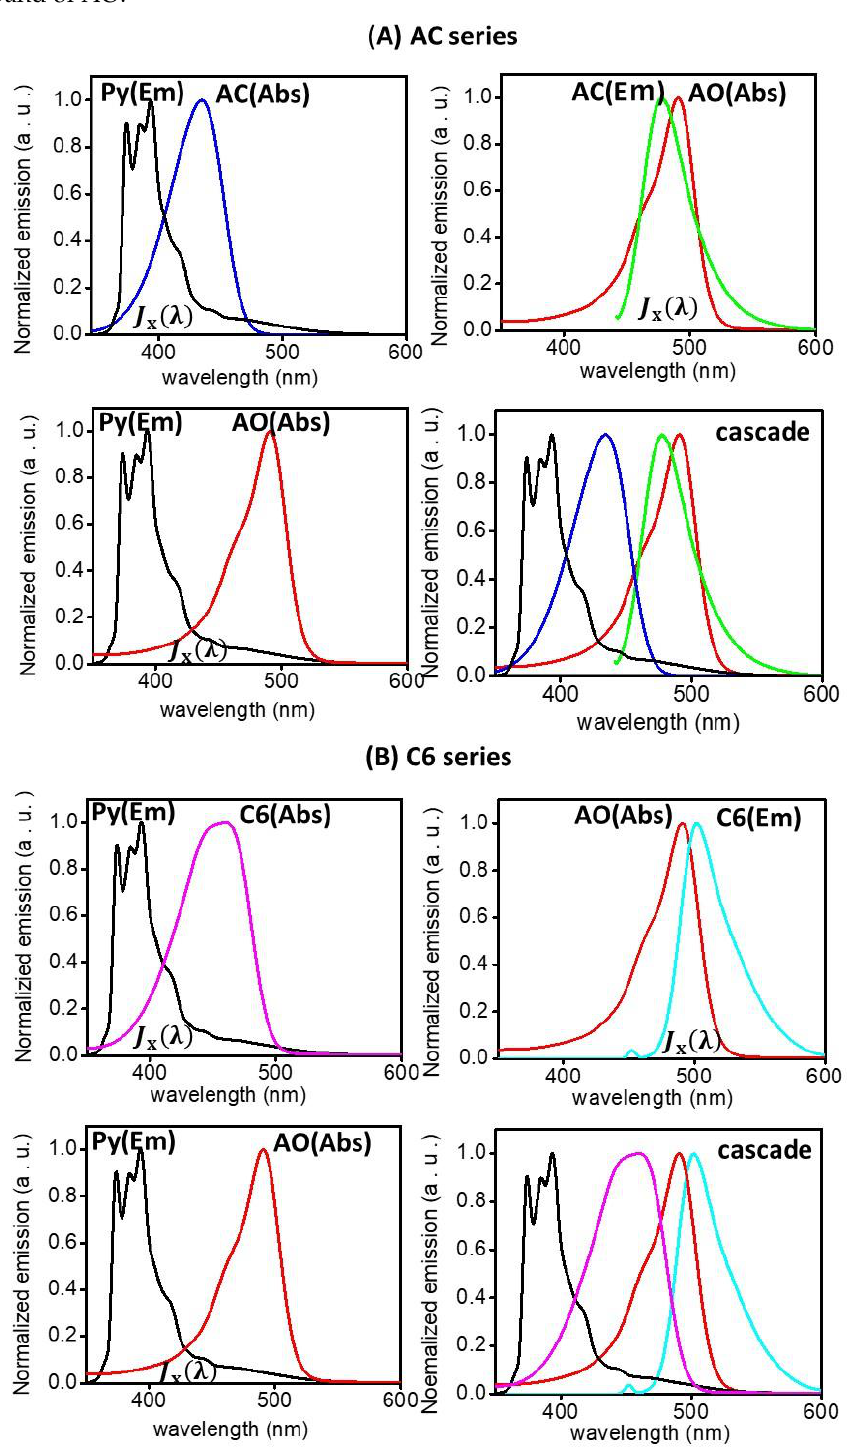
Figure 3. The emission and visible absorption spectral overlaps of ( A ) Py(Em)-AC(Abs), AC(Em)- AO(Abs), Py(Em)-AO(Abs) and cascade FRET process and ( B ) Py(Em)-C6(Abs), C6(Em)-AO(Abs), Py(Em)-AO(Abs) and cascade FRET process. J x (λ) indicates the degree of spectral overlap between the emission band of a donor and the UV-visible absorption band of an acceptor. Figure 4A shows fluorescence spectra of ethanol solutions of Py (3 µM) with AC and AO at different concentrations. The emission of Py decreased with increasing AC content and also slightly decreased with adding AO, although the emission intensity of both AC